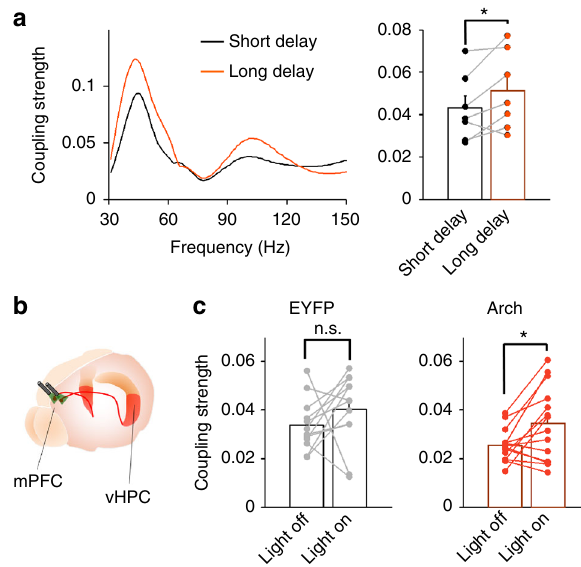
Fig. 5 vHPC theta – mPFC slow gamma coupling is enhanced with the challenge of a working memory task. a Left: example plot demonstrating theta – gamma coupling in short-delay (black) and long-delay (orange) trials. Right: averaged coupling strength in short- and long-delay trials. Coupling between mPFC slow gamma and vHPC theta was signi fi cantly higher in long-delay trials than short delay trials. * p < 0.05; paired t -test. b Schematic of optogenetic inhibition of ventral hippocampal – prefrontal connectivity. Arch-encoding viruses or EYFP-encoding control viruses were injected into the vHPC. vHPC axonal terminals in the mPFC was speci fi cally illuminated to silence mPFC-projecting vHPC neurons. c vHPC theta – mPFC slow gamma coupling in correct trials of control viruses or Arch viruses injected mice. Silencing of vHPC – mPFC projection signi fi cantly enhanced theta – slow gamma coupling (EYFP; p = 0.24, Arch; p = 0.019). * p < 0.05; paired t